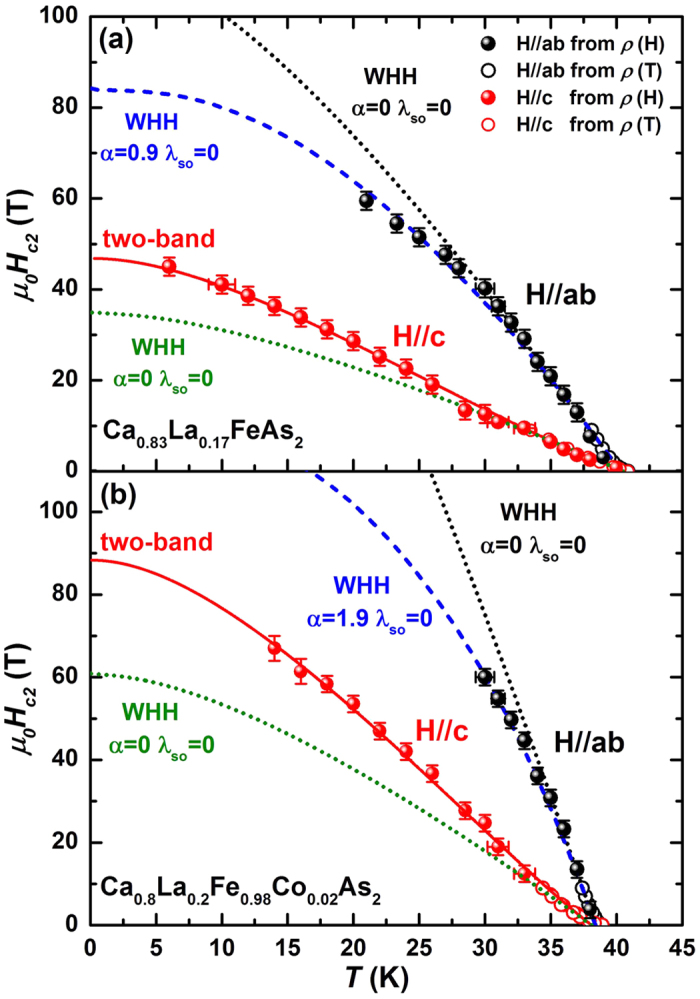
The upper critical field μ0Hc2(T) versus temperature for (a) Ca0.83La0.17FeAs2 and (b) Ca0.8La0.2Fe0.98Co0.02As2 single crystals. Symbols of the open circles and filled circles represent the data obtained in the low magnetic field and pulsed field, respectively. The dotted lines are the WHH fits neglecting the spin paramagnetic effect for H//ab and H//c, respectively, while the dashed lines are the best fits to the experimental data by WHH model with the pauli-limiting effect considered for H//ab. The solid lines for H//c are fitting to the data using the two-band model.